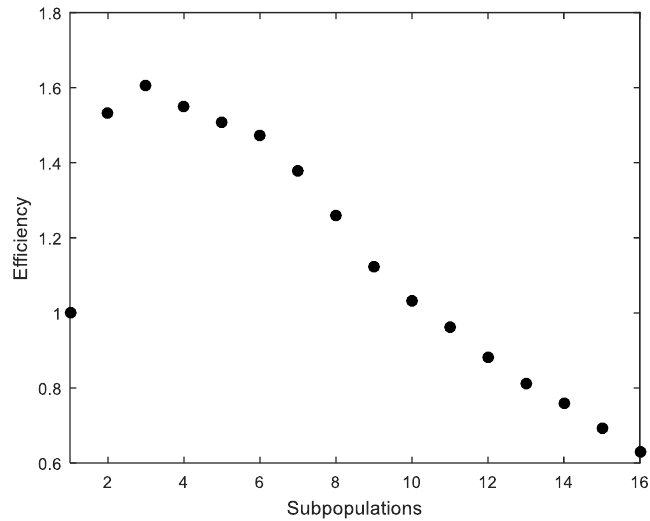
Figure 4. Cross-section under flexure. Efficiency.